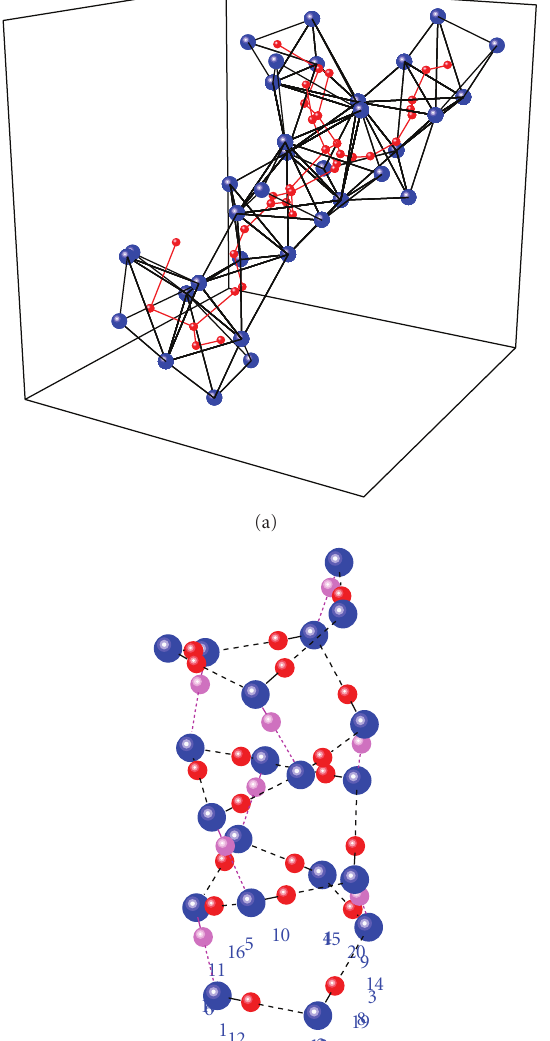
Figure 1: (a) A dense tetrahedral cluster in MD model of liquid water at 300 K and its frame (broken red line); blue points are the molecules and red points are centres of the cluster tetrahedrons; (b) the helical atomic model for this cluster with possible coherent exchange of protons (red balls) between oxygen atoms (blue balls) along the helix of hydrogen bonds (black lines) and hydrogen-bond bridges (pink balls); the projections of oxygen atoms in the plane are denoted by numbers.